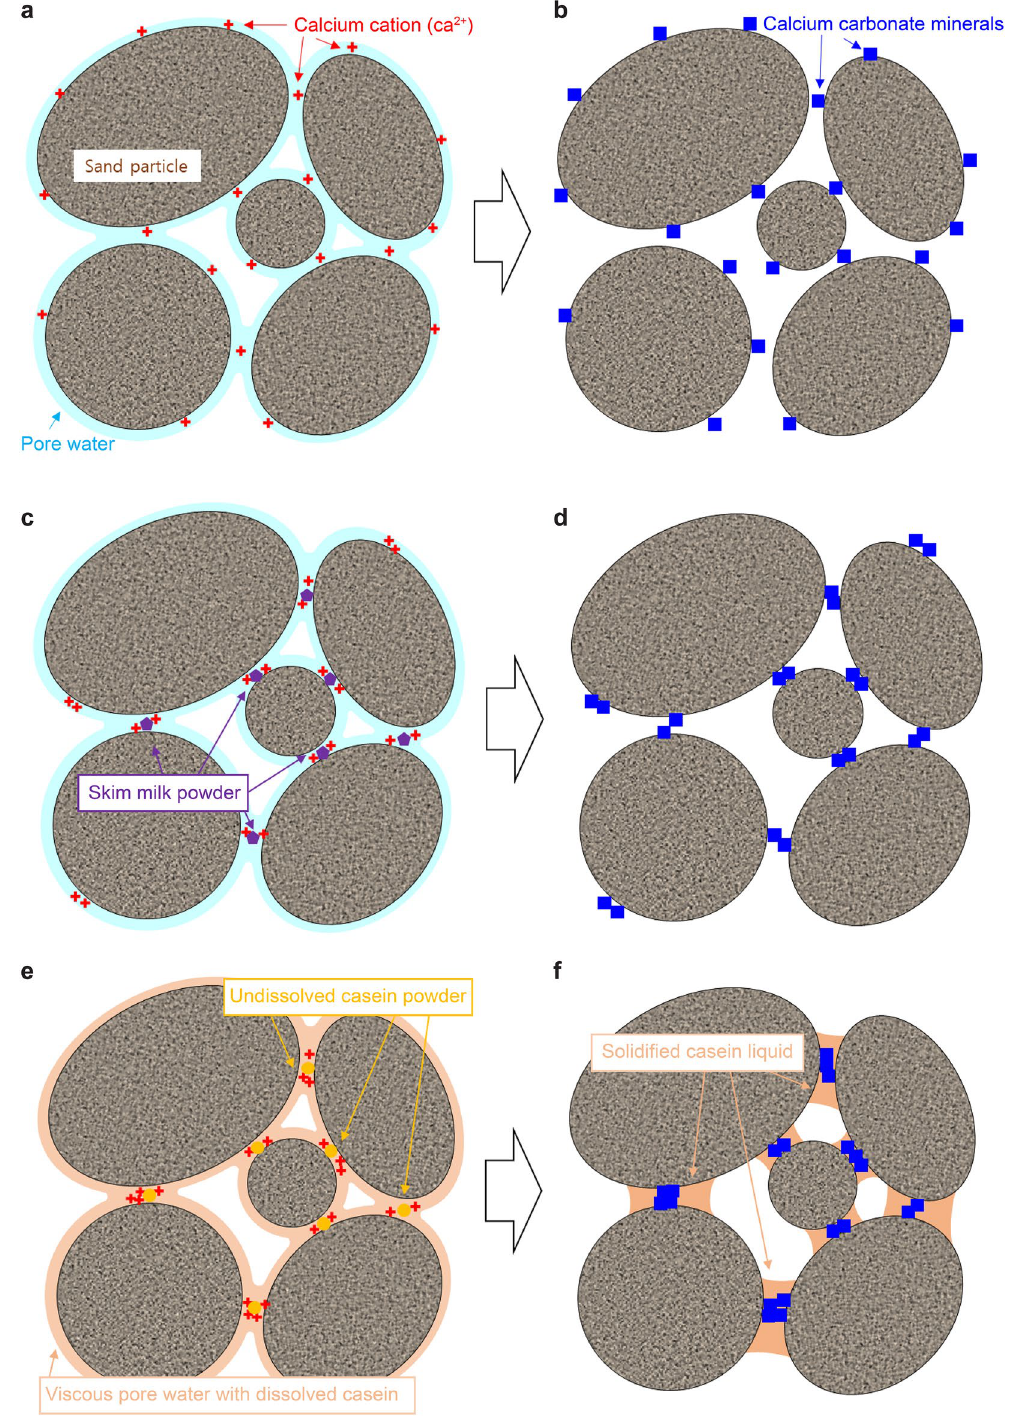
Figure 7. Schematic of the potential biocementation mechanisms via EICP only ( a → b ), EICP assisted using skim milk ( c → d ), and EICP assisted using casein ( e → f